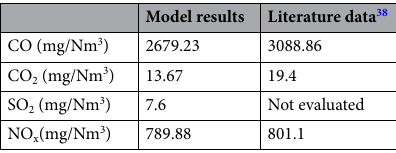
Table 11. Composition of the products of